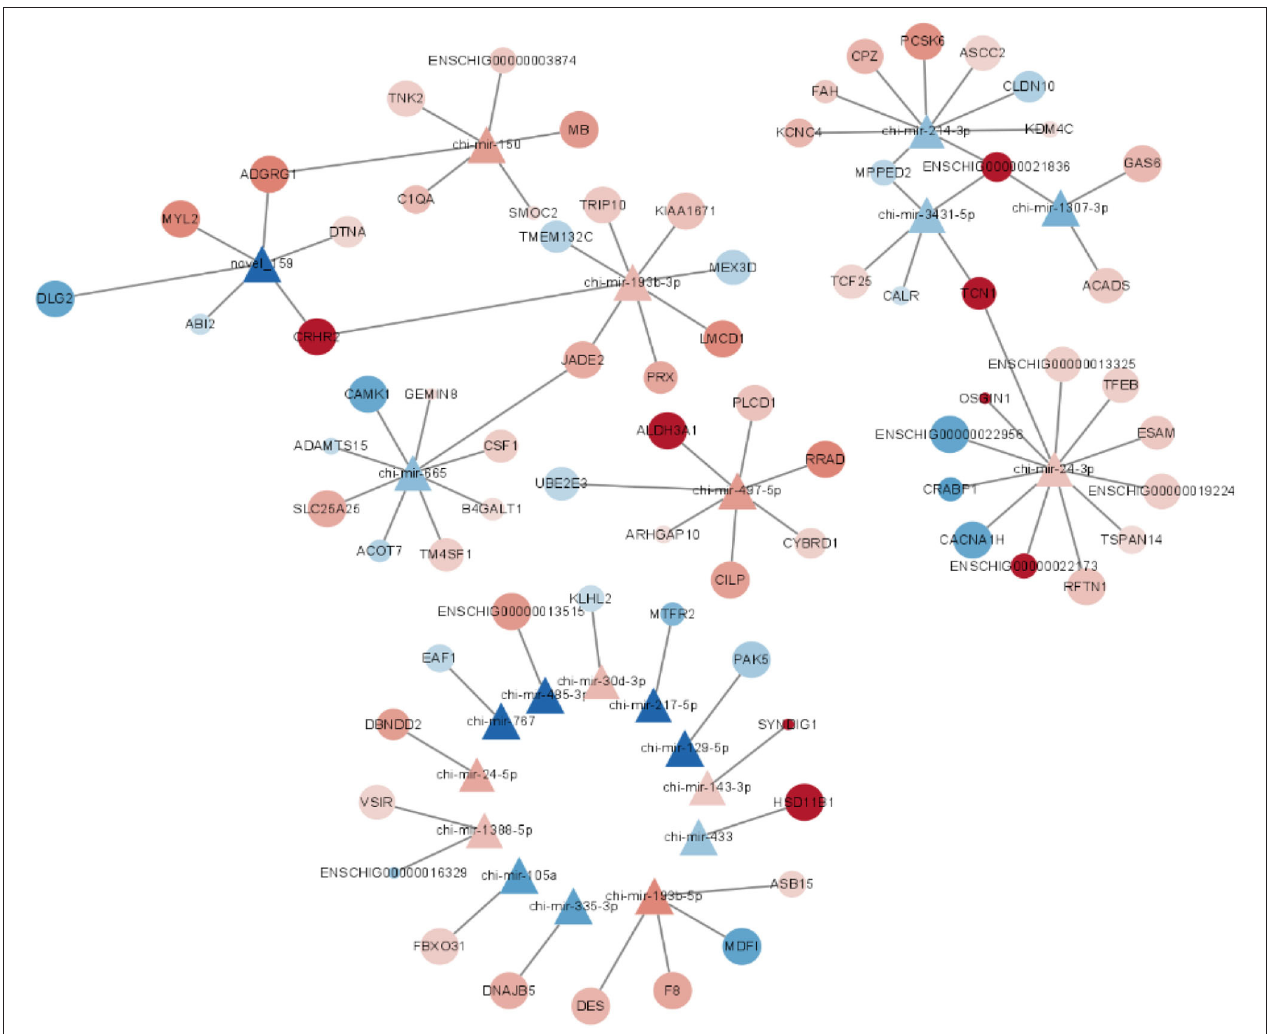
FIGURE 5 | Interaction network map of the differentially expressed mRNAs targeted by M120 vs. M90 differentially expressed